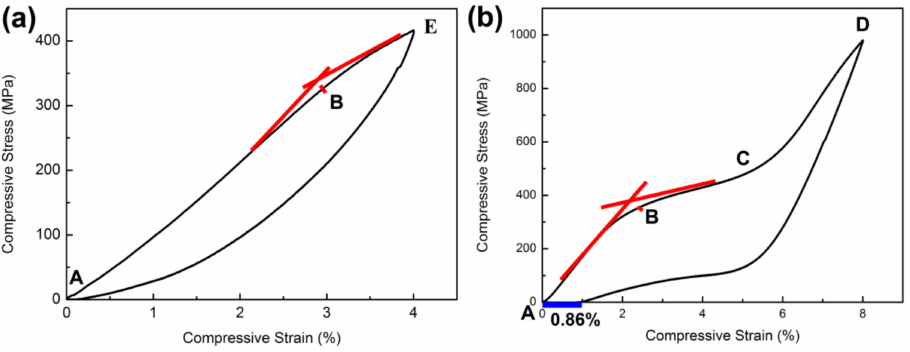
Figure 4. Stress–strain curve of compression: ( a ) 4% deformation and ( b ) 8% deformation.